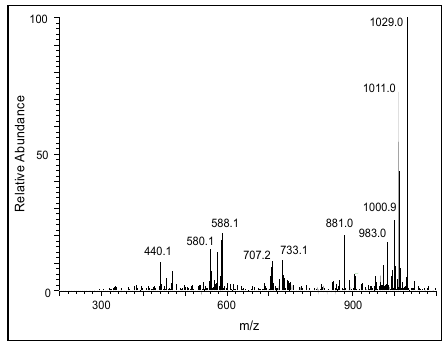
Figure 11. The CID mass spectrum of the ion with an m / z value of 1029 amu.